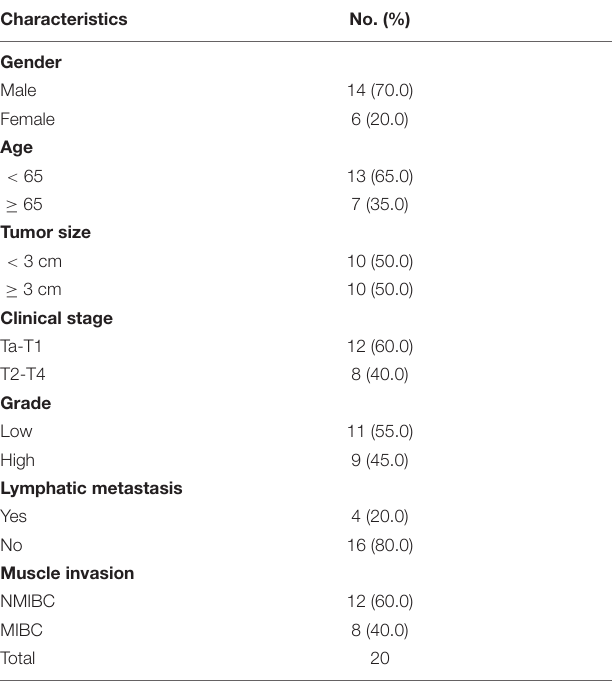
TABLE 5 | Clinicopathological features of 20 fresh bladder cancer for Flow cytometry analysis.